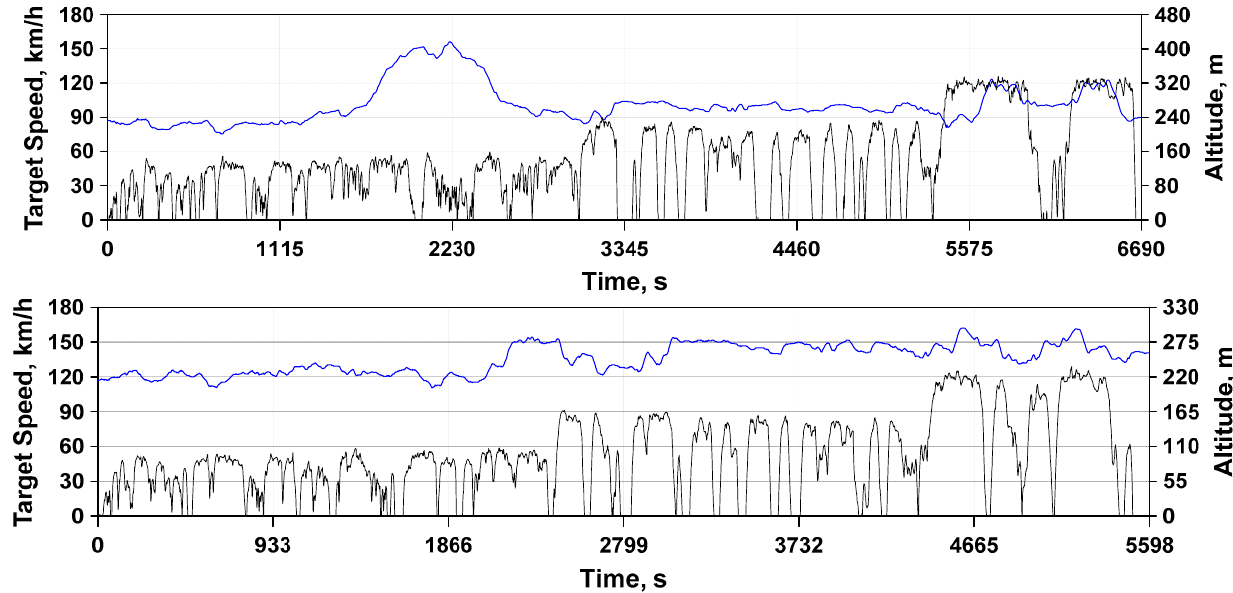
Figure 7. RDE-compliant cycles target speed and altitude